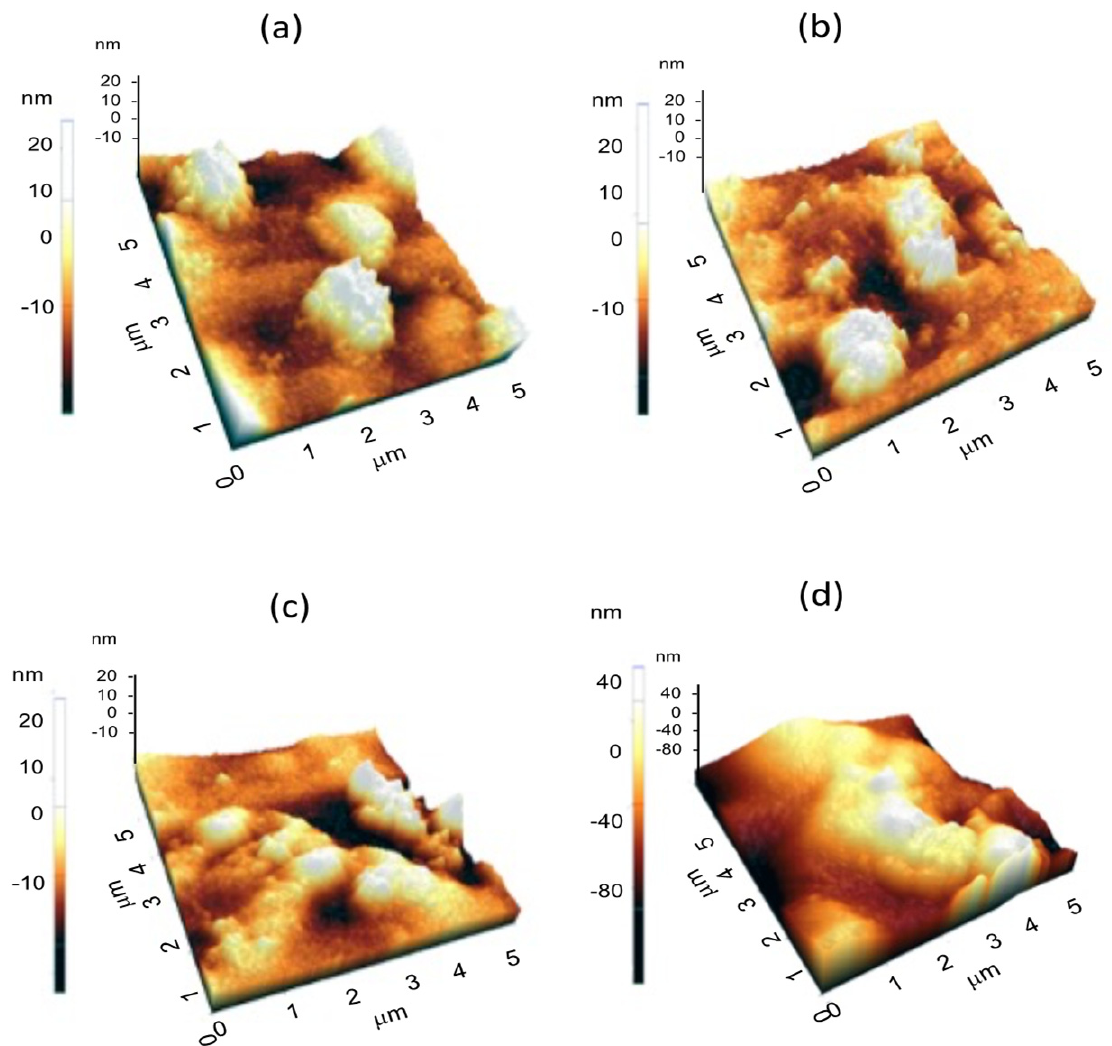
Figure 3. Images of the morphologies of chitosan (CH) and squid gelatin hydrolysates (SGH) films at 1000 × magnification: ( a ) 100 CH/0 SGH, ( b ) 90 CH/10 SGH, ( c ) 80 CH/20 SGH, and ( d ) 60 CH/40 SGH.